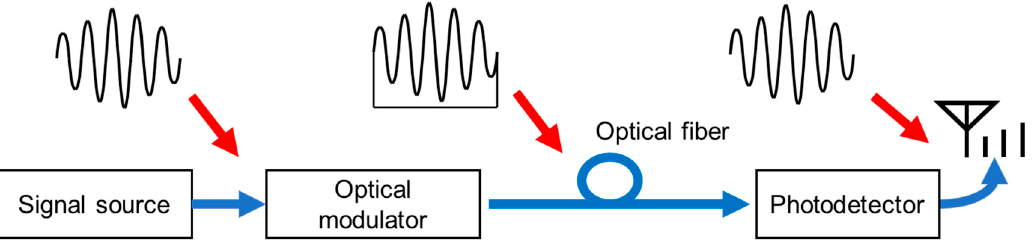
Figure 1. Schematic of a radio-over-fiber (RoF) system.